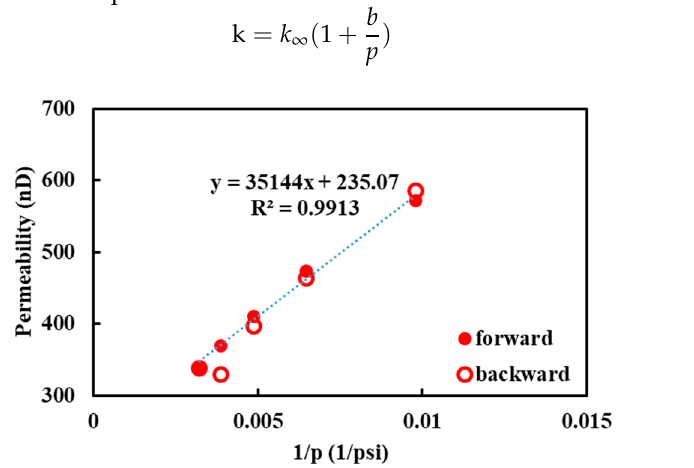
Figure 7. Schematic showing the first and second halves of the core sample and flow directions.